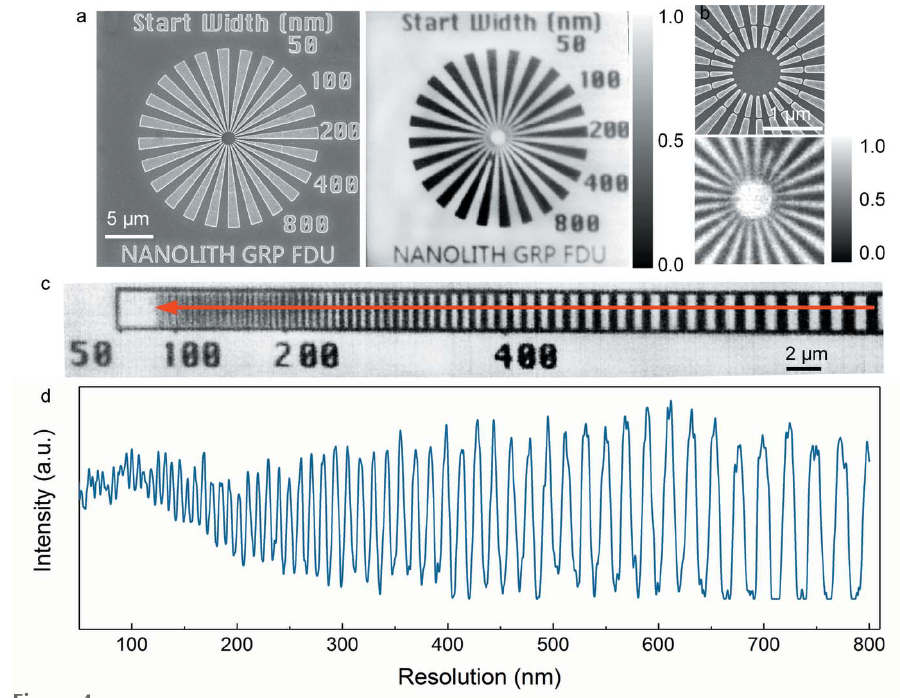
Figure 4 Results of soft X-ray imaging tests for the fabricated HSQ kinoform zone plate. ( a ) SEM image (left) of the in-house-made Siemens stars with resolution of 30 nm and soft X-ray image (right) of the same target at 500 eV with photon flux of 5 (cid:4) 10 9 photons s (cid:2) 1 . The dwelling time is 1 ms and step size is 50 nm, using the HSQ-KZP lens as focusing component. ( b ) SEM image and soft X-ray STXM image of the magnified central part of the Siemens star, using the HSQ-KZP lens at 500 eV with dwelling time of 1 ms and 25 nm step size. The colour bars in ( a ) and ( b ) are normalized photon flux. ( c ) Image of an in- house-made grating with variable pitches, on which the red arrow line shows the scanning with a dwelling time of 2 ms and step size of 30 nm, using the HSQ-KZP lens as focusing component. ( d ) Intensity profile of the test grating over 50 pitches as outlined in ( c ) by the red arrow